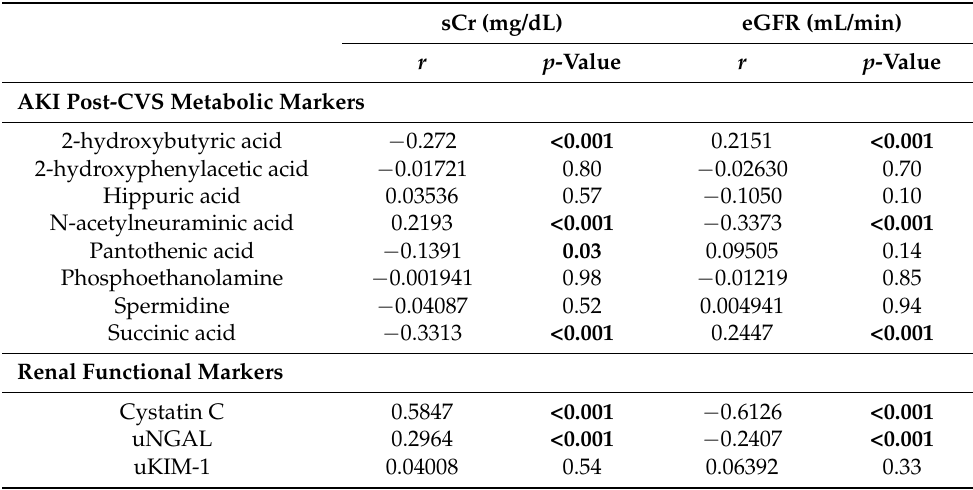
Table 2. Spearman correlation values for metabolites and proteins with sCr and eGFR are